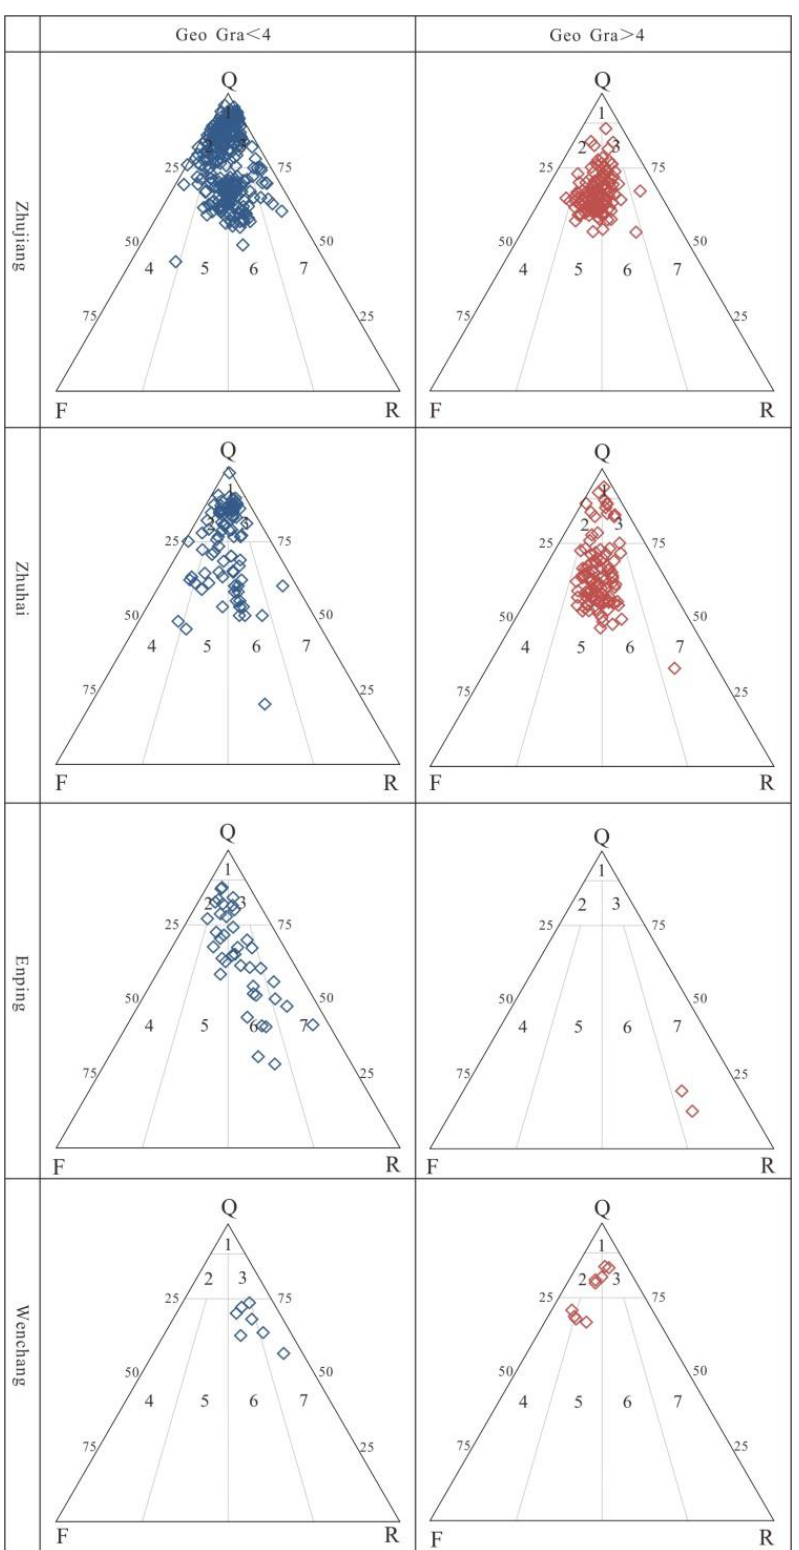
Figure 2. The samples plotted on the QFR (Quartz, Feldspar, Lithic ratios) ternary diagram. (1—Quartzarenite; 2—Subarkose; 3—Sublitharenite; 4—Arkose; 5—Lithic Arkose; 6—Feldspathic Litharenite; and 7—Litharenite). Sandstone classification scheme from Reference [27]. The sandstone types of the Zhuhai group are basically the same in different locations, while those of the Zhujiang, Enping, and Wenchang groups are different. Exception for quartzarenite, other sandstone types in Zhujiang Group are consistent in the high and low geothermal gradient